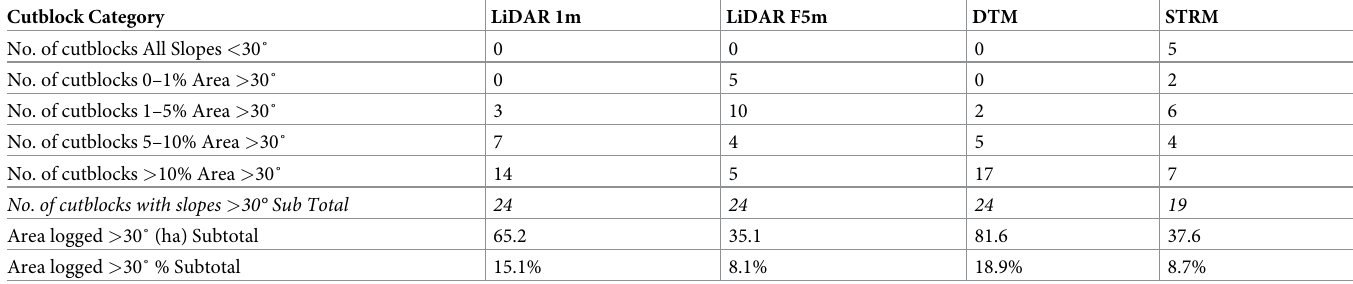
Table 2. Cutblocks calculated with slopes > 30˚ logged across Block 318 using LiDAR at 1 m resolution, LiDAR with a 5m (LiDAR F5m) average slope neighbour- hood, the Shuttle Topography Radar Mission (STRM 1 arc sec) at a 1 arc second resolution and the VicMap Elevation DTM (VicMap DTM) at 10m resolution. Cutblock Category LiDAR 1m LiDAR F5m DTM STRM No. of cutblocks All Slopes <